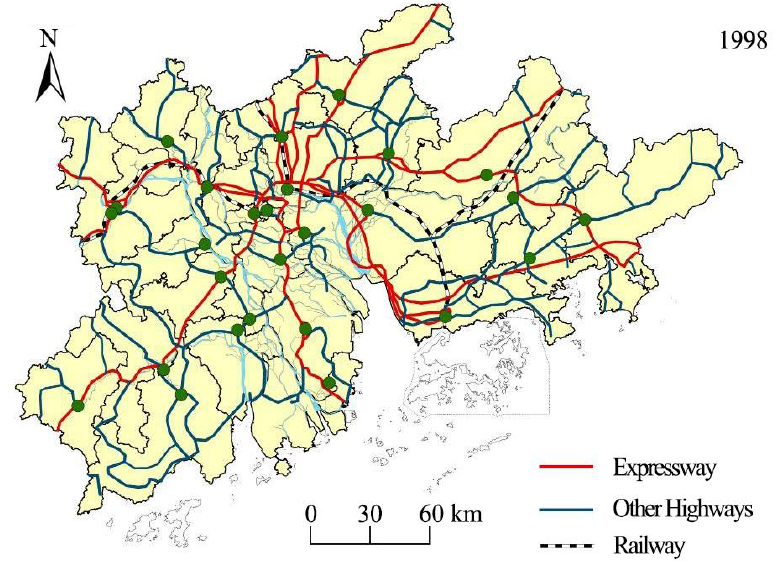
Figure 2b: The evolution of land-based transport network in the PRD, 1998